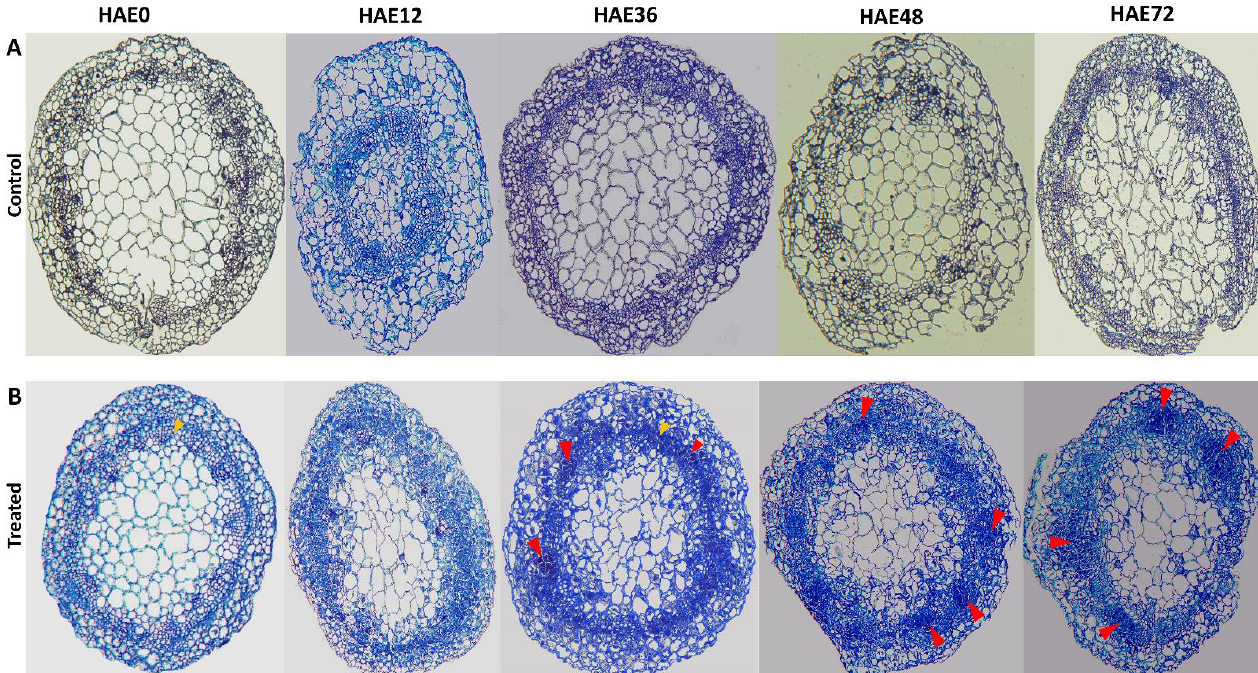
Figure 1. Histological observations of dark-pretreated micro-shoot cuttings (IBA and non-IBA) of tetraploid R. pseudoacacia L. during AR formation process at 0, 12, 36, 48, and 72 HAE, in which only treated micro-shoots were subjected to 0.2 mg L − 1 IBA. ( A ) Histological observations of control (non-IBA), dark-pretreated micro-shoot cuttings, with no changes at mentioned HAE. ( B ) Histological observations of treated (IBA), dark-pretreated micro-shoot cuttings with apparent changes at HAE. Yellow arrows indicate the cambium layer, red arrows represent the first mitotic cell divisions and first AR primordium development on the cambium layer.